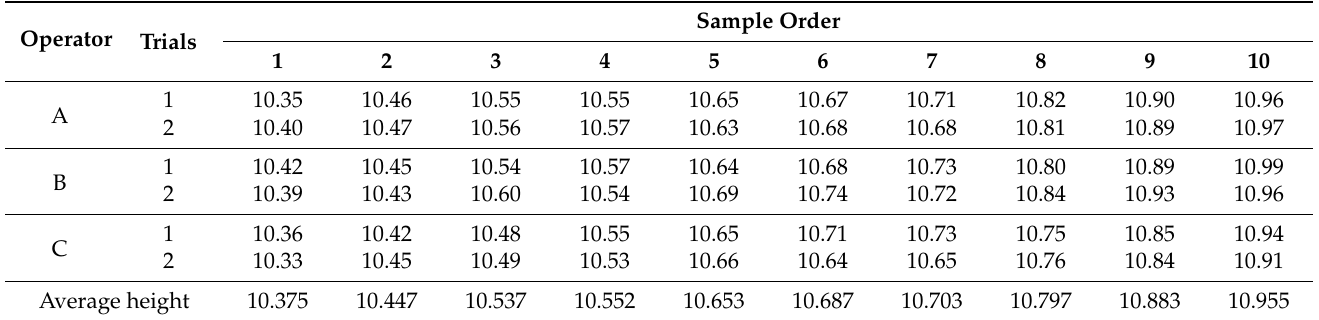
Table 3. Measured data of nut height (in mm) for the arranged